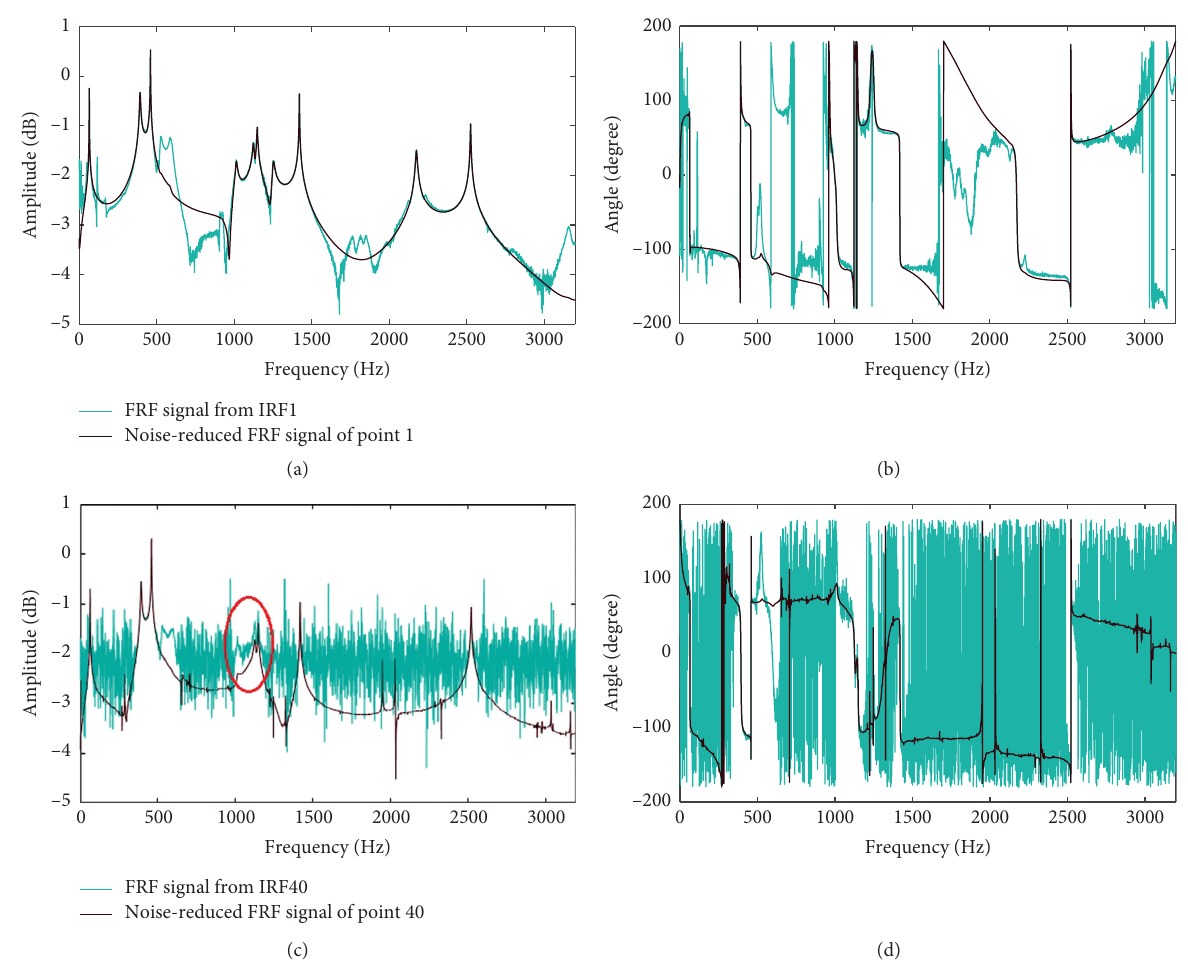
Figure 14: Noise reduction result of Points 1 and 40. (a) Energy spectrum of Point 1. (b) Phase spectrum of Point 1. (c) Energy spectrum of Point 40. (d) Phase spectrum of Point 40.